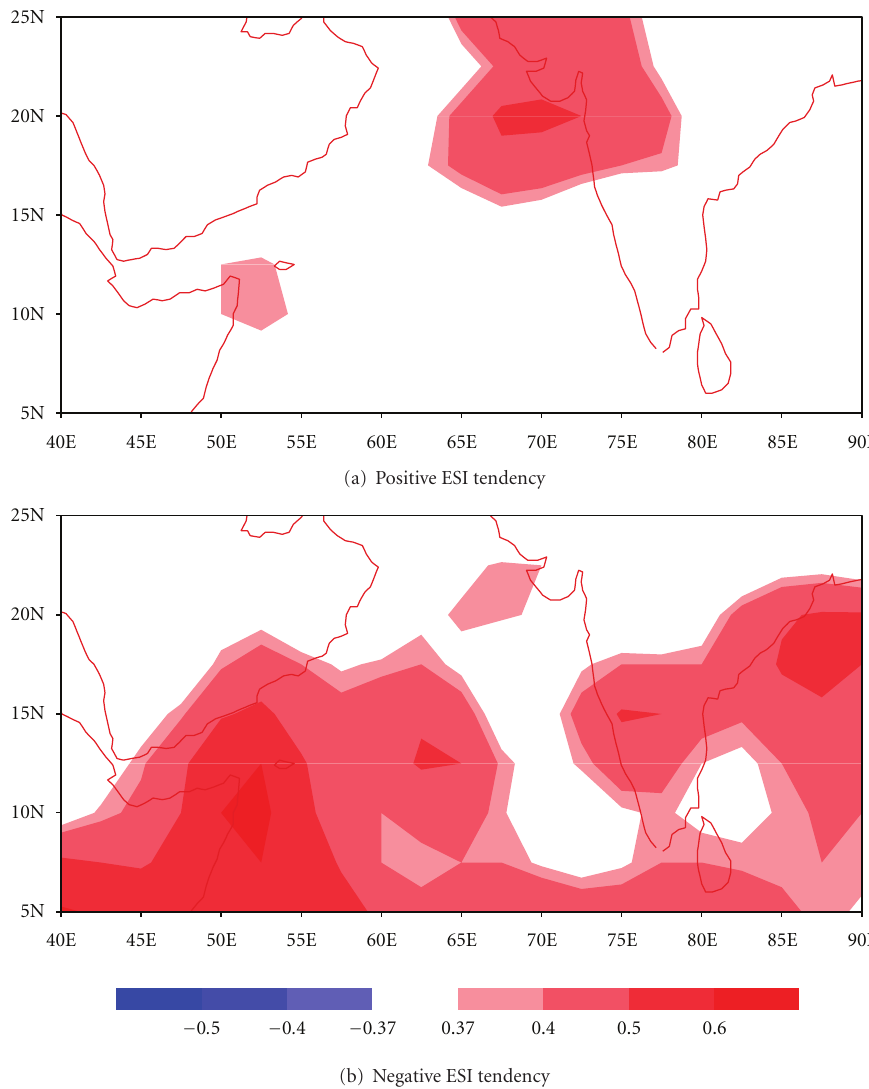
Figure 5: The correlation coe ffi cients between winter Nino3 SST anomaly and annual 1000-hPa temperature anomaly over Arabian sea and Bay of Bengal (5 ◦ –25 ◦ N, 40 ◦ –90 ◦ E) during (a) positive and (b) negative ESI tendency.